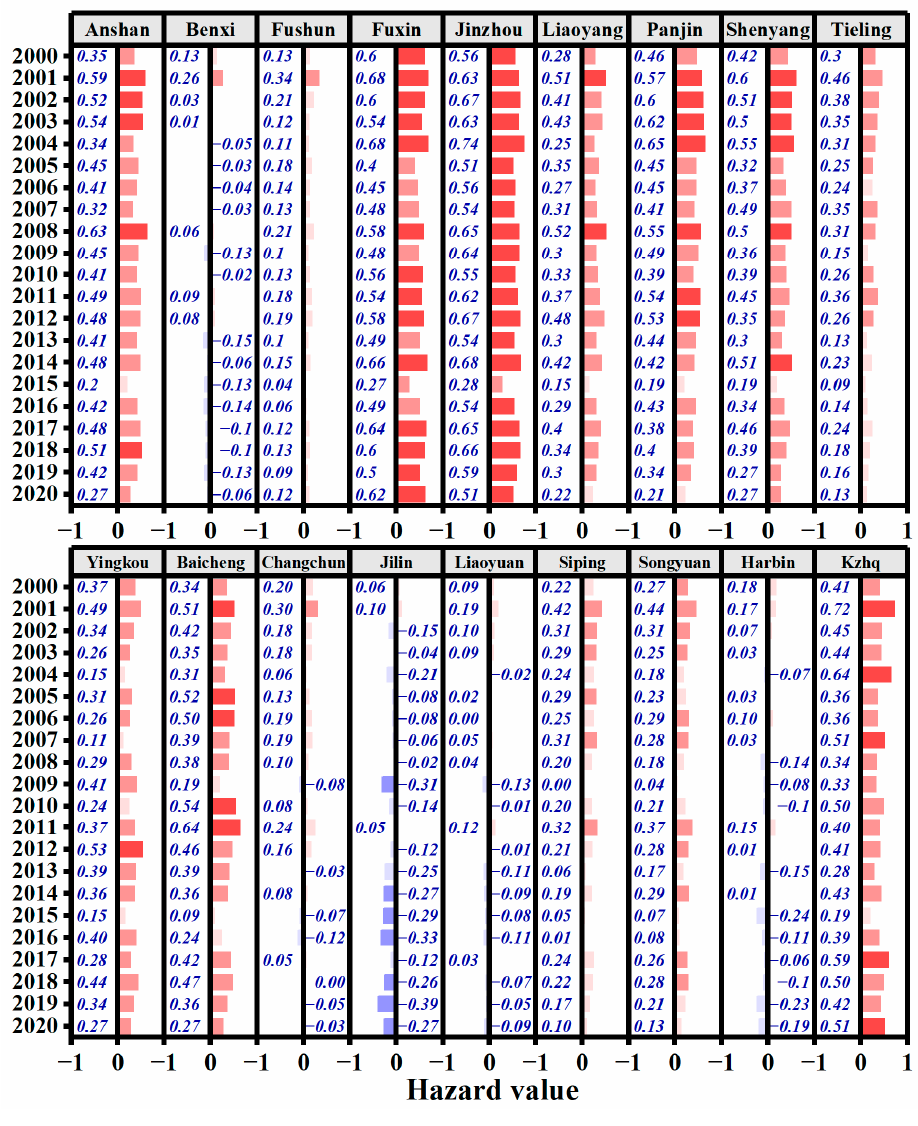
Figure 12. Trends in annual average hazard values in the 18 regions from 2000 to 2020.